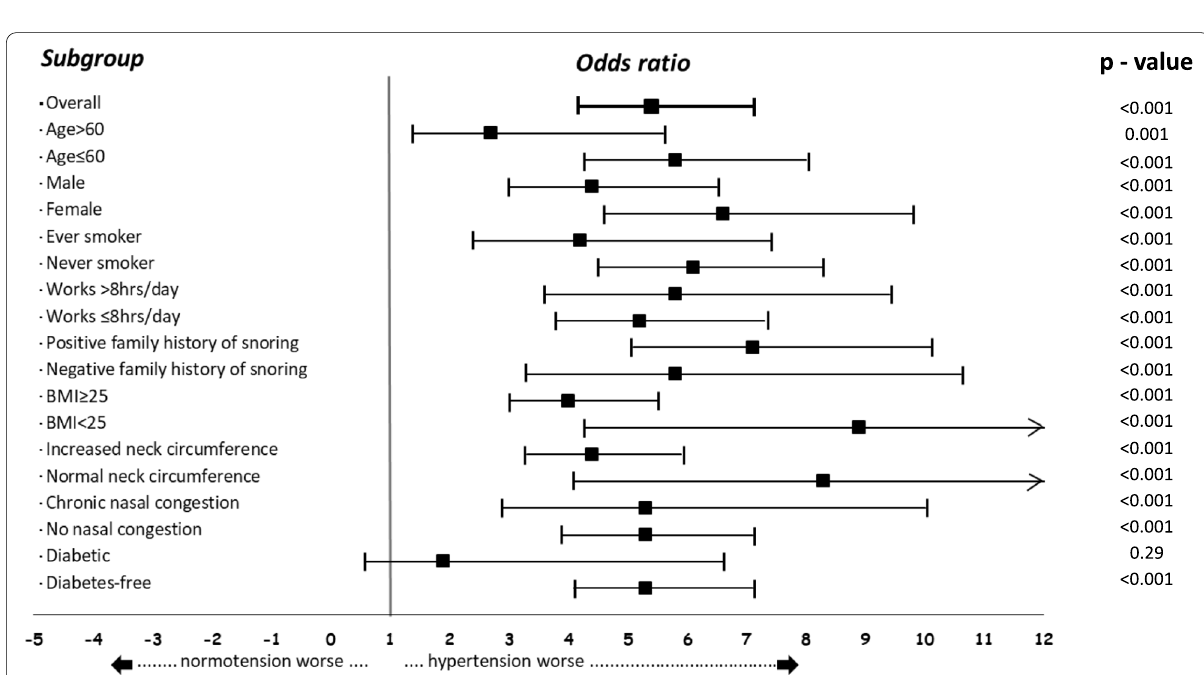
Fig. 1 Odd ratios for OSA by hypertension status. This forest plot shows the odd ratios (black squares), 95% CIs (horizontal lines), and p -values for the interaction between OSA and any subgroup variable by hypertension